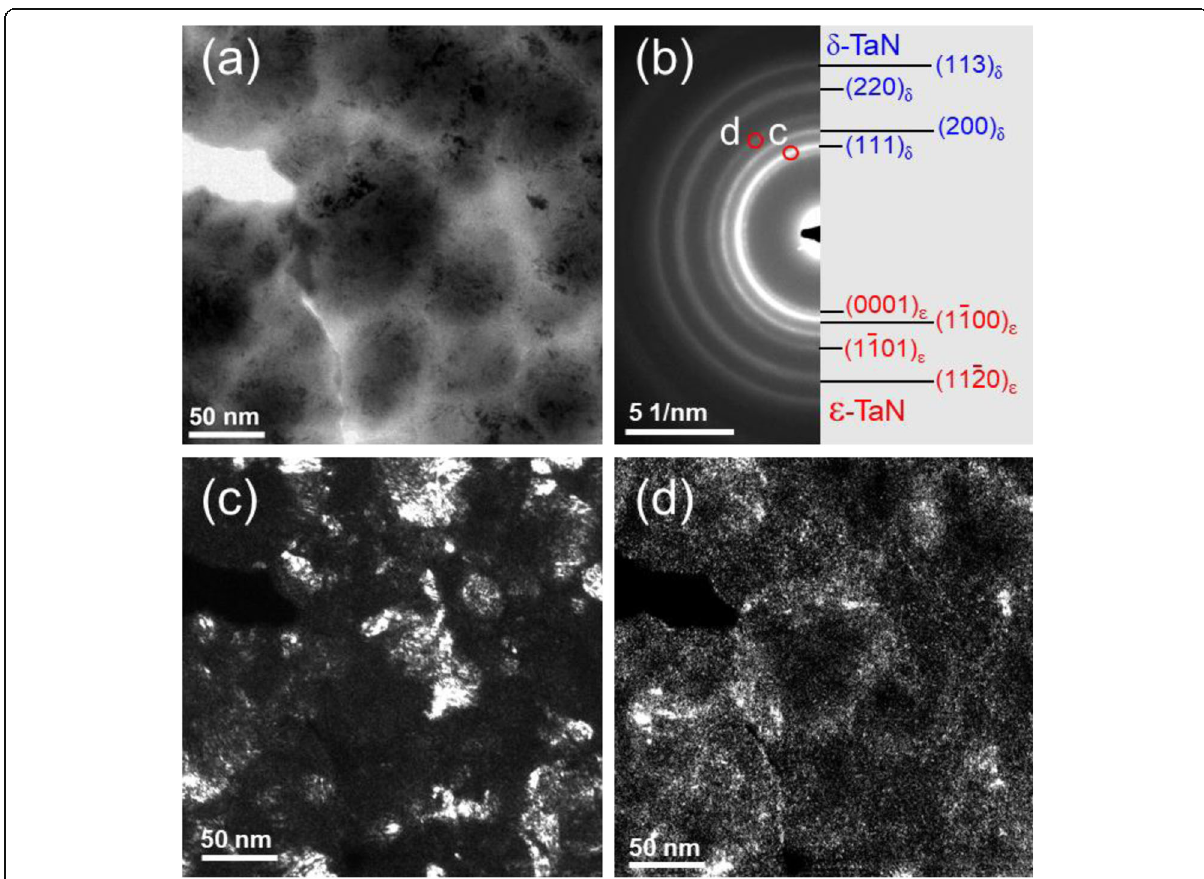
Fig. 5 PTEM images of TaN x film grown with 0.15 f N2 for 100 W ICP power. (a) BF TEM image, (b) SADP and its indexing, (c, d) Dark-field (DF) TEM images of δ - TaN (111), and ε - TaN ð 1121 Þ reflections in TaN x